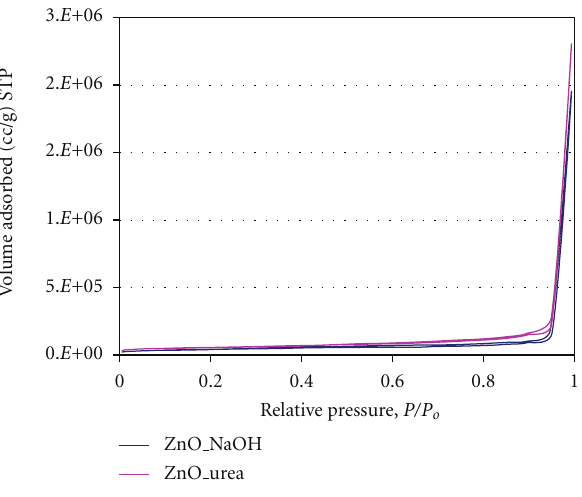
Figure 7: The influence of catalyst concentration on R 6G decol- orization (pH = 10, 50ppm initial dye